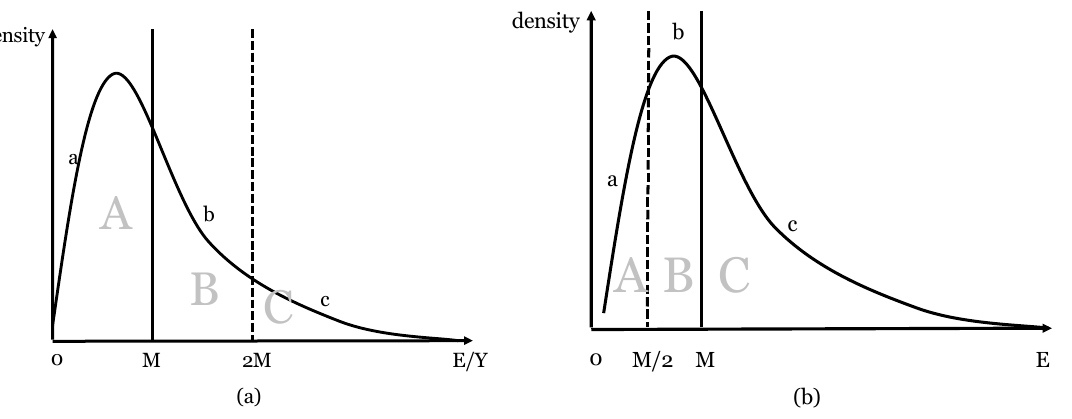
Figure 1. Schematic representation of HS ( a , left ) and LA ( b , right ) indicators.